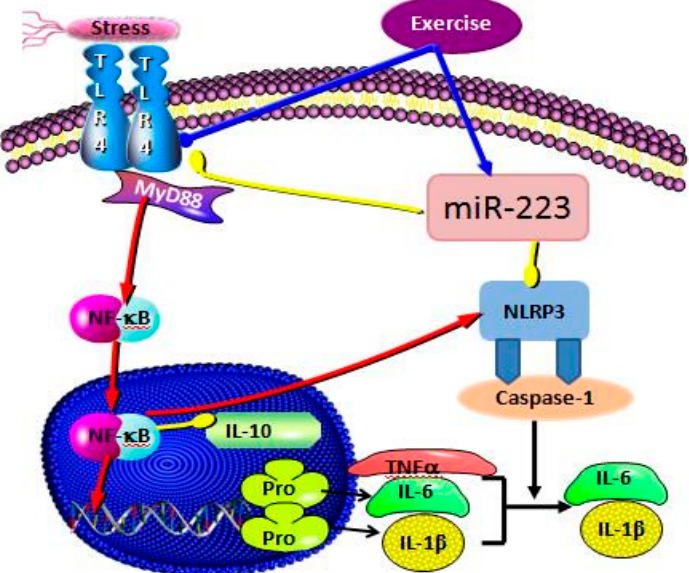
Figure 8. The activation mechanism of miR-223 negative regulation of the TLR4 / MyD88-NF- κ B signaling pathway.